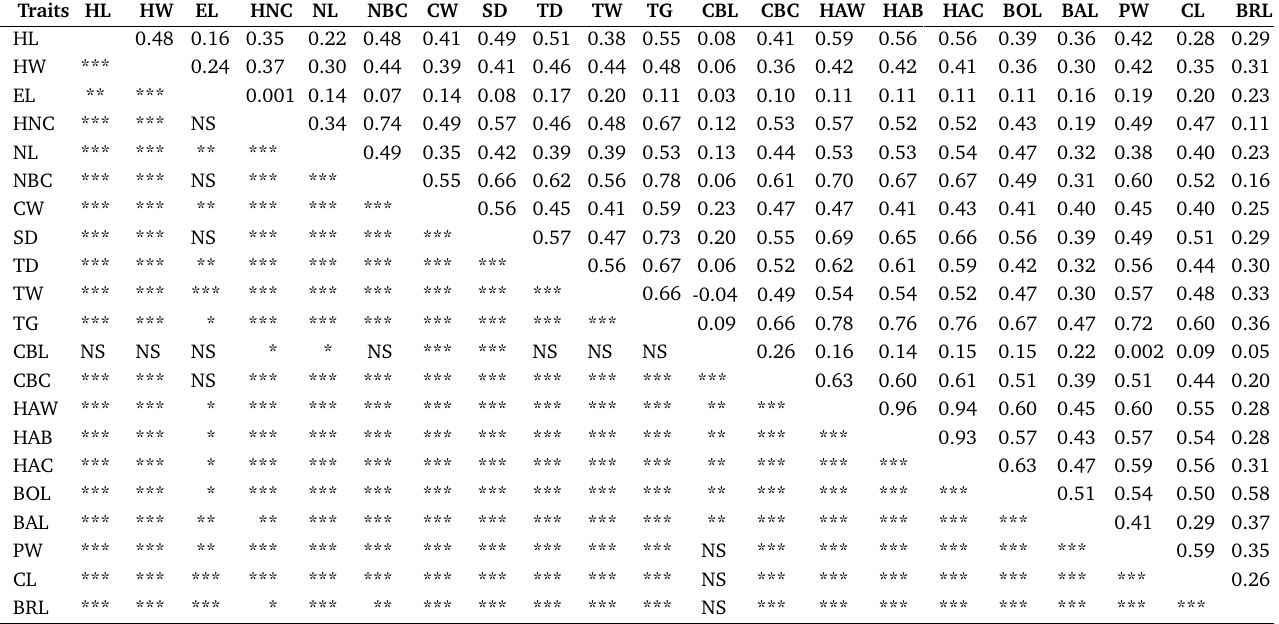
Table 7. Pearson correlation coefficients between each morphometric measurement (above diagonal) and level of significance (below diagonal) of the horses (both sexes) from the three locations. HL, Head length; HW, Head width; EL, Ear length; HNC, Head neck circumference; NL, Neck length; NBC, Neck body circumference; CW, Chest width; SD, Shoulder depth; TD, Thorax depth; TW, Thorax width; TG, Thorax girth; CBL, Cannon bone length; CBC, Cannon bone circumference; HAW, Height at withers; HAB, Height at back; HAC, Height at croup; BOL, Body length; BAL, Back length; PW, Pelvic width; CL, Croup length; BRL, Barrel length. *, p < 0.05; **, p < 0.01; ***, p < 0.0001; NS, Not Significant.